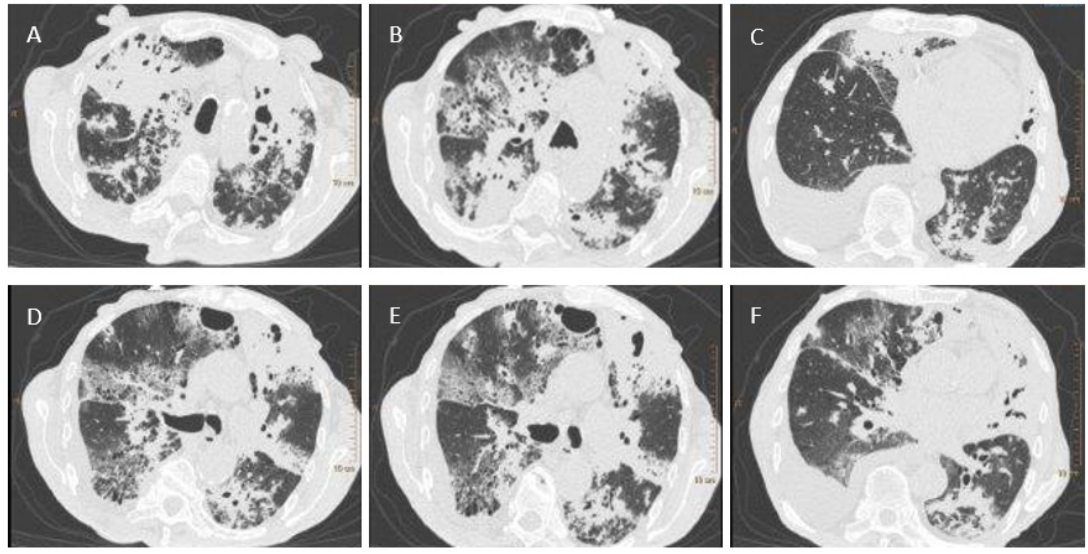
Figure 1. Figure 1. Chest CT scans. ( A )—parenchymal-atelectatic lesions; thick-walled cavities filled with masses of tissue decay in the upper lobes; ( B )—parenchymal-atelectatic lesions; cavities filled with tissue decay in segment 3 of the right and left lung, with the accompanying areas of tree-in-bud-appearance in segment 3 of the left lung and in the apex of segment 6 of the right and left lung; ( C )—fluid in the pleural cavity; ( D – F )—tree-in-bud-appearance in the apex of segment 6 of the right lung and in segments 6–9 of the left